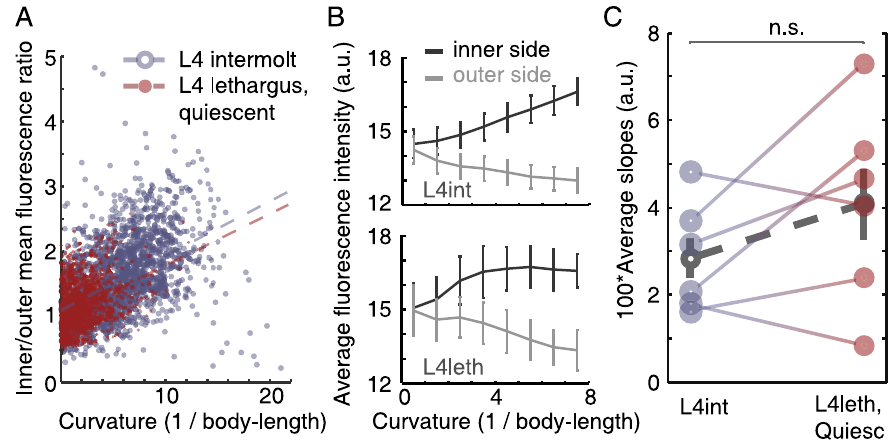
Figure 2. Bends are actively maintained during lethargus quiescence bouts. (A) Values of curvature at all positions along the body were plotted against the ratio of fluorescence of a calcium reporter expressed in the inner and outer body-wall muscles at the same bend. All points plotted were measured from a single animal during L4int (blue, empty circles) and during L4leth bouts of quiescence (red, filled circles). Dashed lines denote the linear correlations between the curvature and the ratio of fluorescence during L4int (blue) and L4leth (red). In this example, the slope of the linear fit during L4int was similar to that during L4leth, indicating a similar relation between body curvature and GCaMP fluorescence in the two developmental states. (B) The absolute values of GCaMP fluorescence that were measured at the inner and outer sides of the body bend during L4int (top) and L4leth (bottom). Similar mean values were obtained at the two stages (N=6 animals, error bars depict 6 s.e.m). (C) Pairwise comparisons of the slopes obtained from N=6 animals, all analyzed as demonstrated in panel (A). The slopes during L4int and L4leth were not significantly different (p . 0.2), indicating that static body bends during quiescence bouts were actively maintained. Dashed line (grey) depicts mean 6 s.e.m.